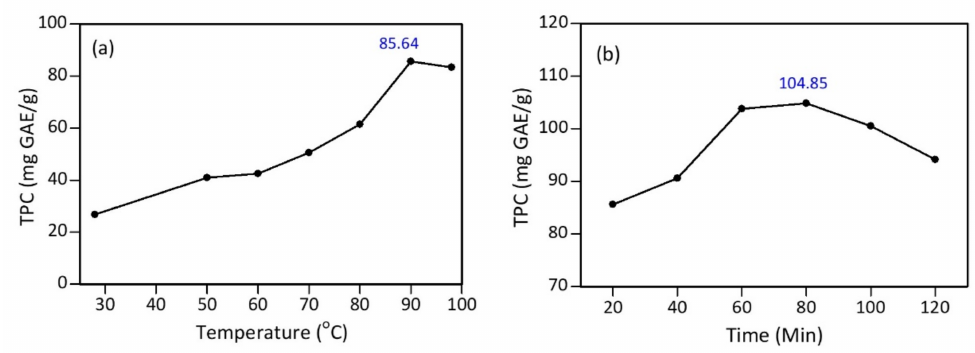
Figure 3. Total polyphenol content (TPC) of tea extract: ( a ) variation of temperature with 20 min heating; and ( b ) variation of heating time at 90 ◦